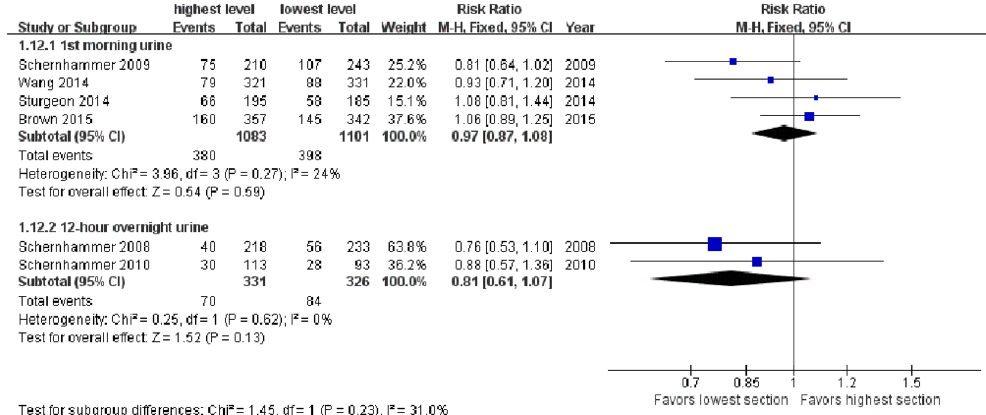
Figure 7. Forest plot for the association between urinary 6-sulfatoxymelatonin levels in first morning (upper sub-figure) and 12-hour overnight (lower sub-figure) urine samples and breast cancer